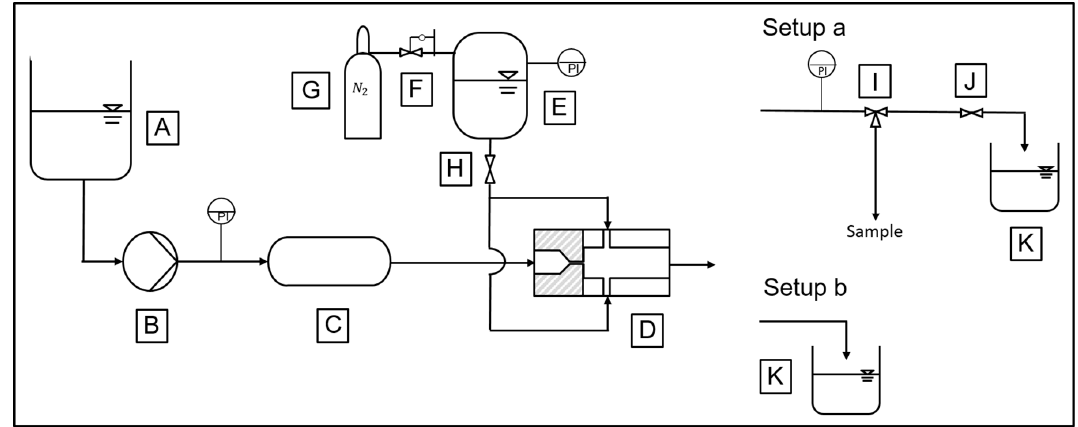
Figure 3. Setup of the experimental plant. Setup a is used for trials with applied back-pressure, setup b for trials in which the outlet pressure equals atmospheric pressure.